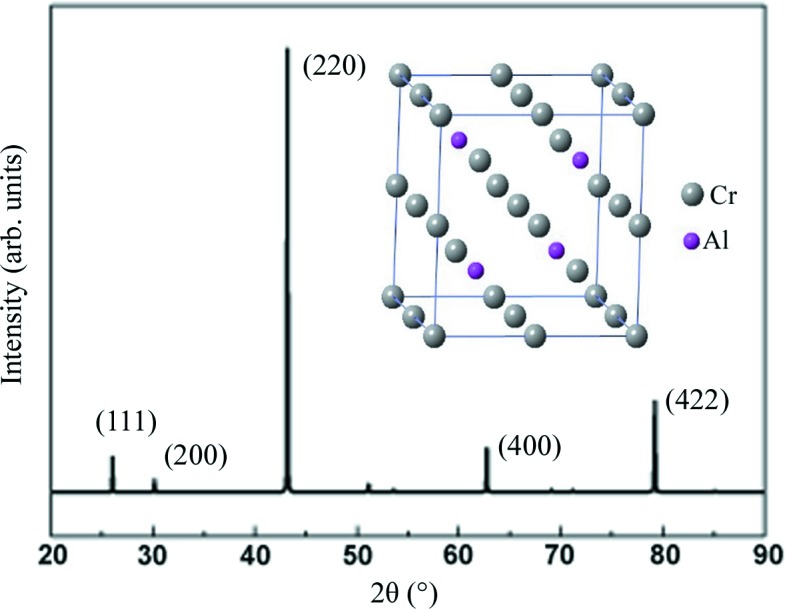
Theoretical powder XRD pattern for the Cr3Al compound with a DO3 structure; the inset is the structure model.